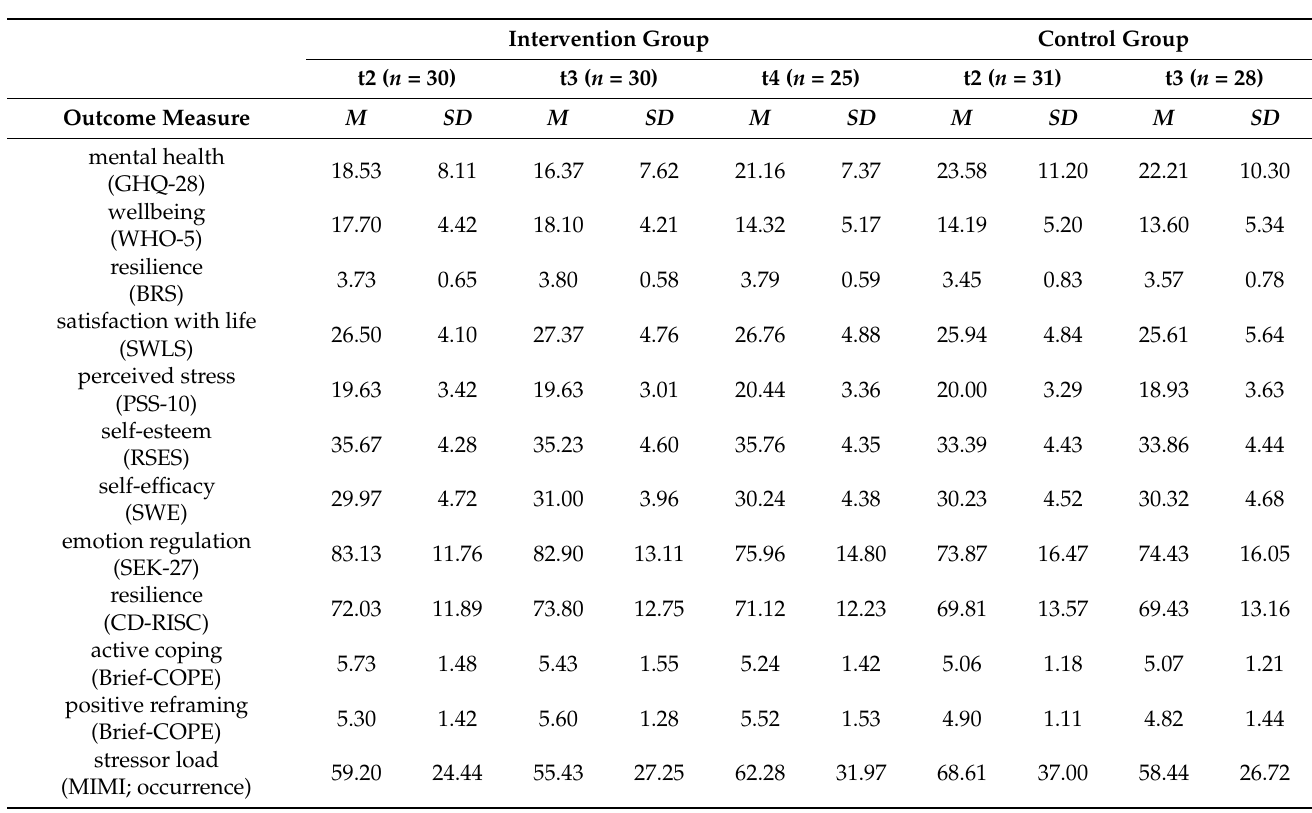
Table 3. Descriptive statistics for follow-up data (t2–t4).